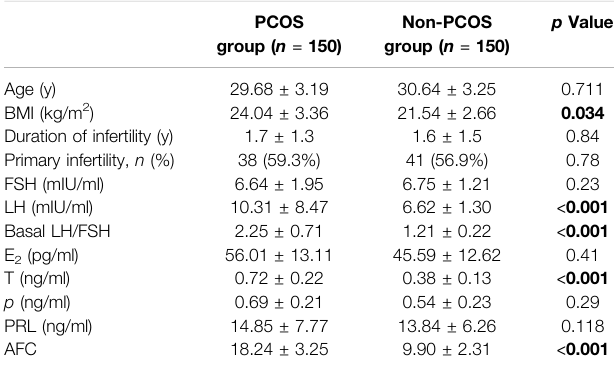
TABLE 1 | The clinical characteristics of women with PCOS and non-PCOS